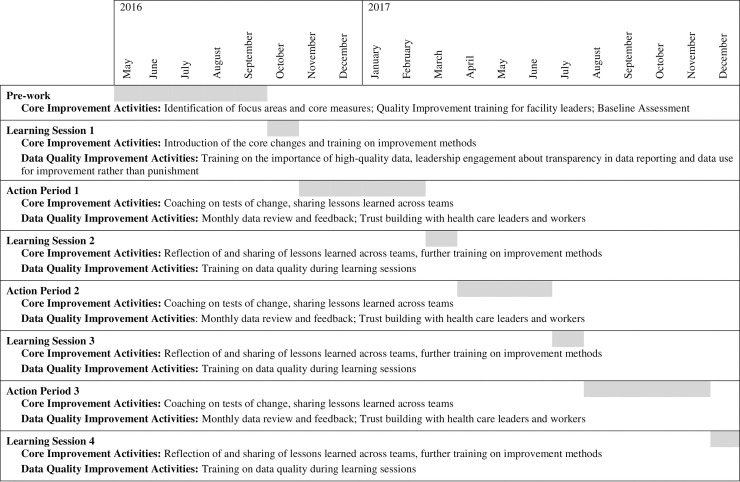
Summary of the core improvement activities and embedded data quality improvement activities.